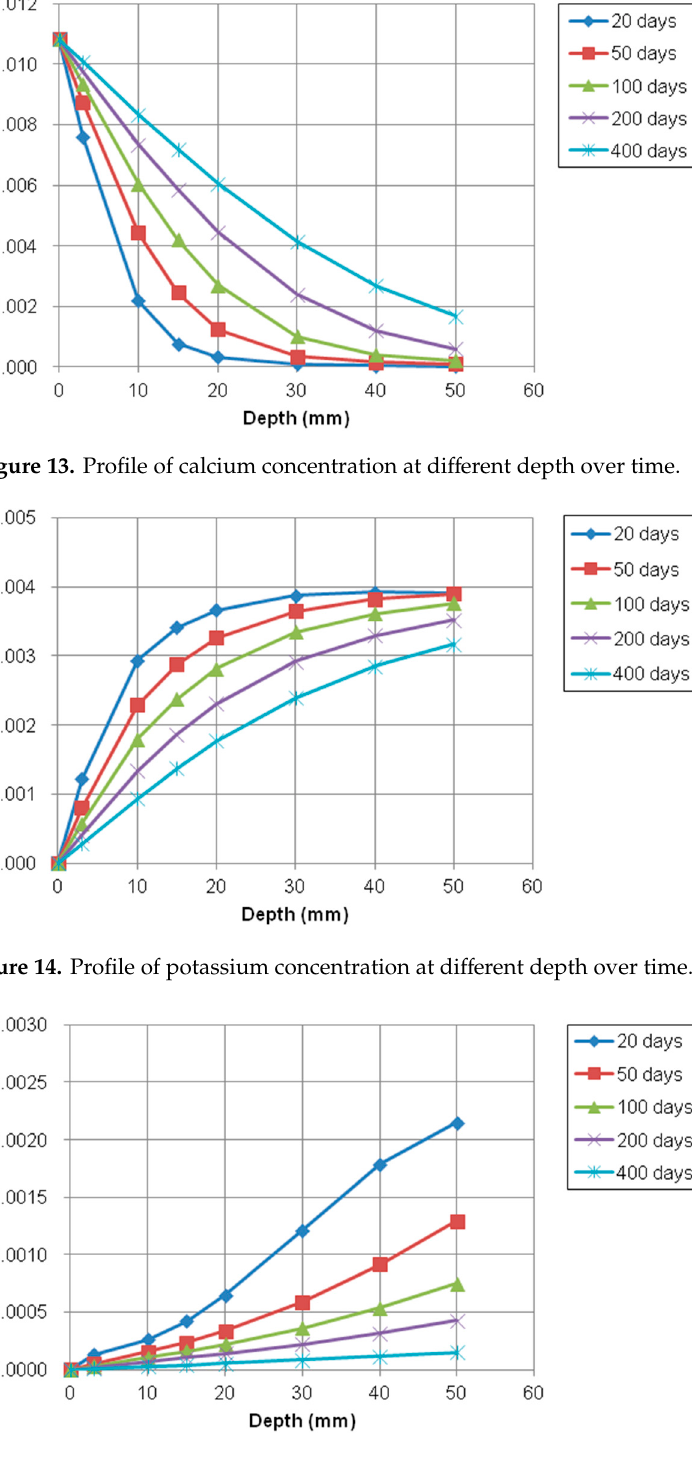
Figure 15. Profile of hydroxyl concentration at different depth over time.